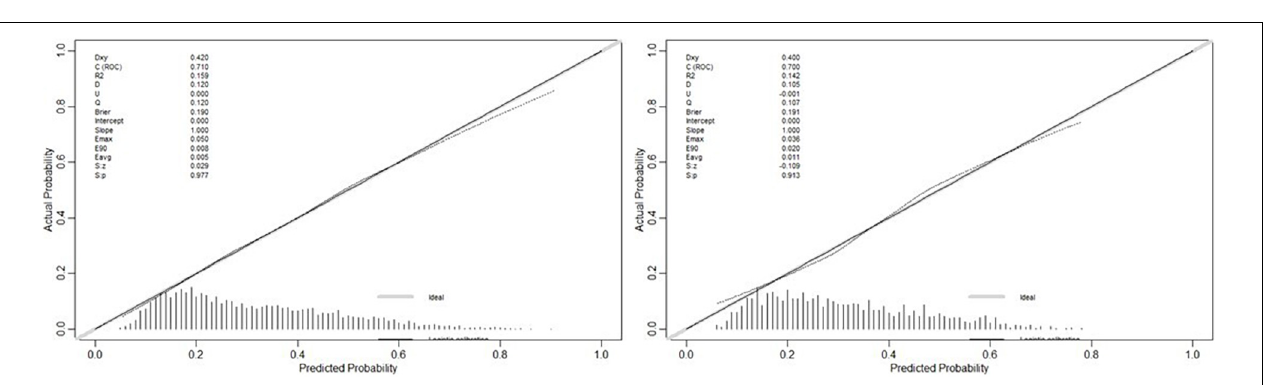
FIGURE 3 | Receiver operating characteristic (ROC) curves of the model in training and validation dataset.